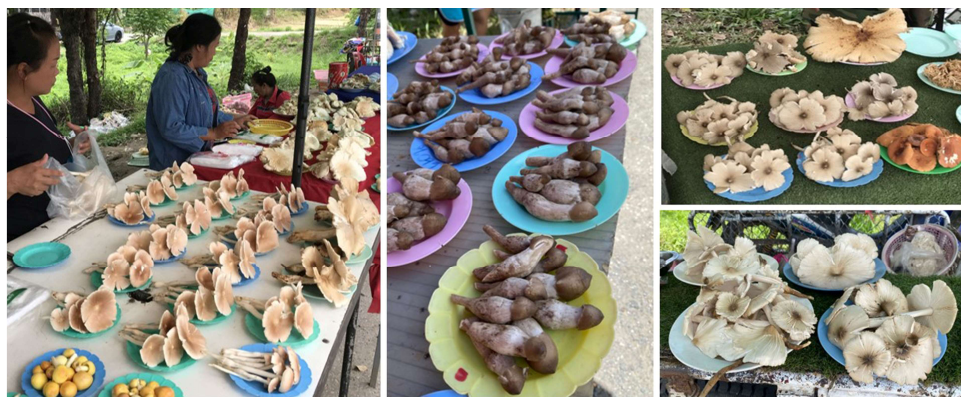
Figure 3. Some Termitomyces species are sold in the Thai local and roadside markets. Photo credit: Suwannarach, N.